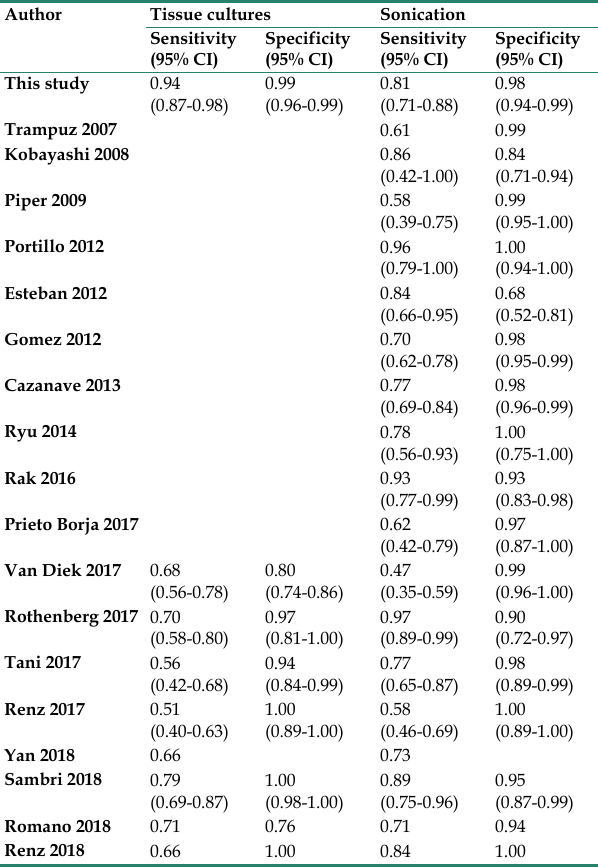
Table 2. Sensitivity and specificity of tissue and sonication cultures, compared to the